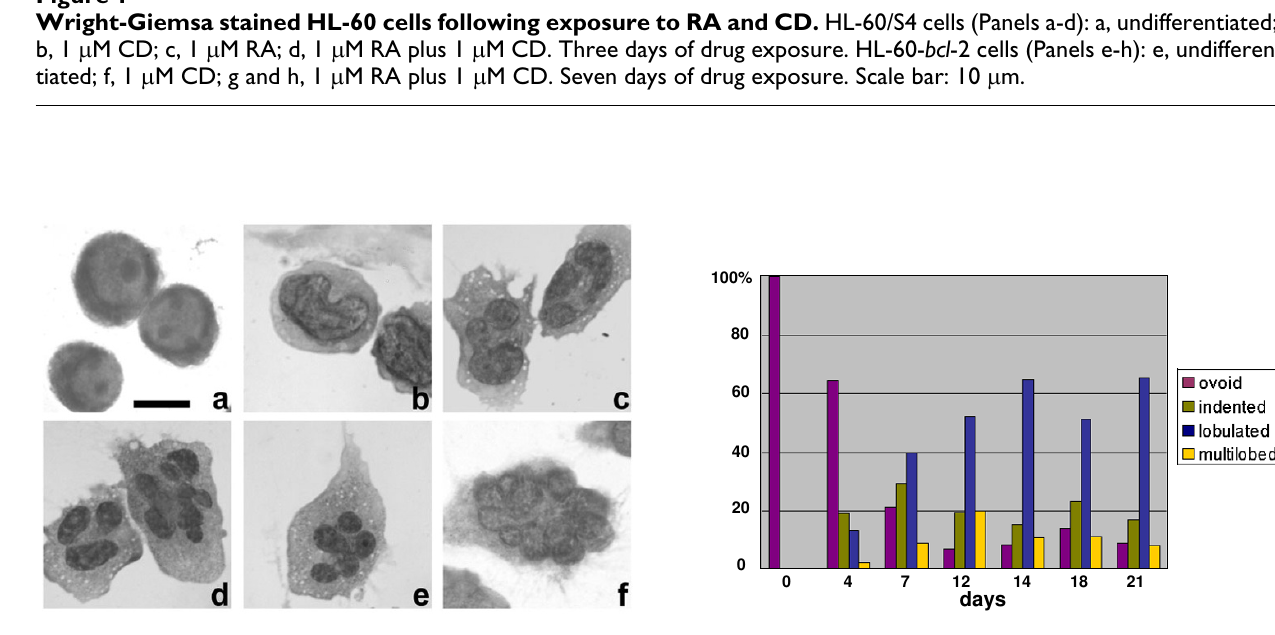
Wright-Giemsa stained HL-60 cells following exposure to RA and CD. HL-60/S4 cells (Panels a-d): a,